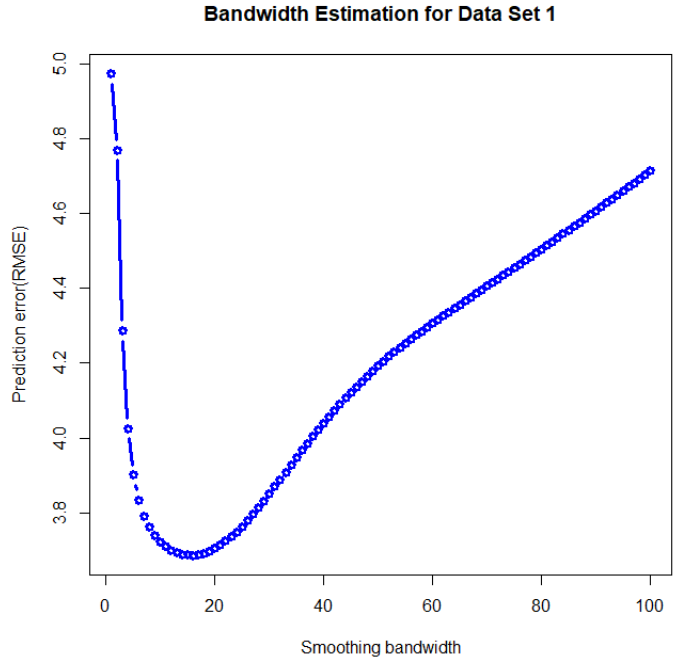
Figure 3. By increasing the bandwidth from small to large, we calculate the RMSE of the estimation and examined at what value of the bandwidth the corresponding RMSE is the minimum.